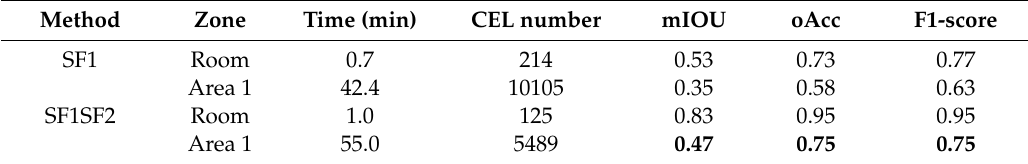
Table 6. Analyses of the impact of feature sets over samples of the S3DIS dataset.